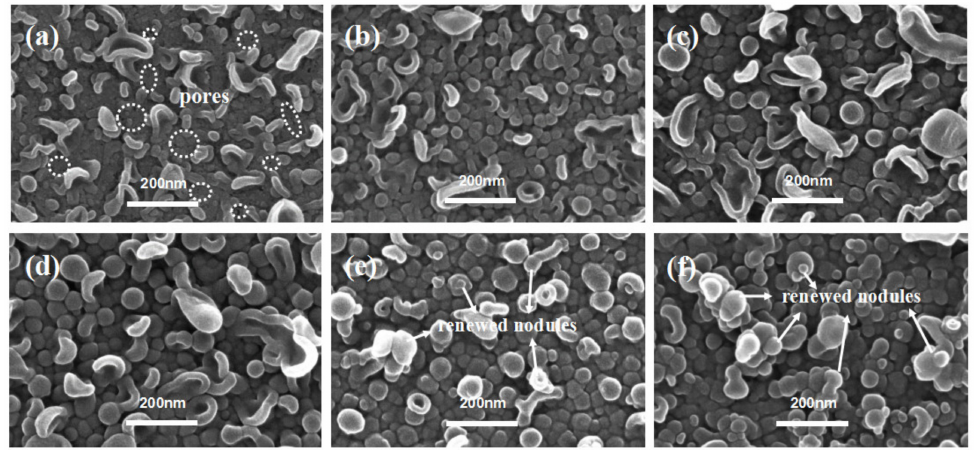
Figure 7. SEM images of PA’s top surface in series 3. ( a – f ): TFC − 13~TFC − 18.